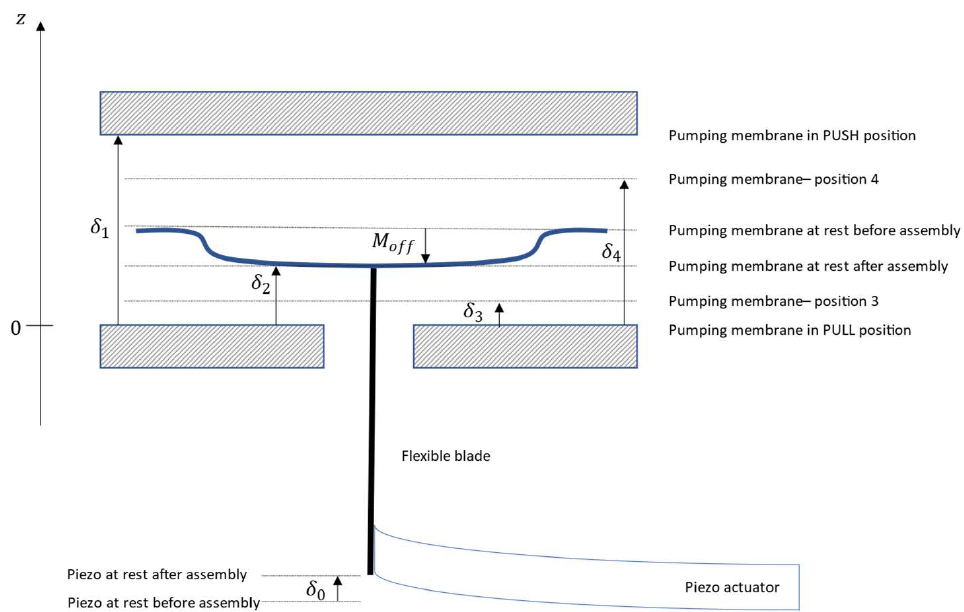
Figure 7. Schematic view (not to scale) of the piezo and the pumping membrane at specific positions defined in the different methods used hereafter. The origin z = 0 was chosen at the pull position of the membrane. The pumping membrane and the piezo actuator offsets were noted; M of f and δ 0 correspond to their respective displacement along the z-axis during assembly. The different strokes δ 1 to δ 4 correspond to the pumping membrane displacement during the compression tests #1 to #4 (a detailed description of these tests is provided in the